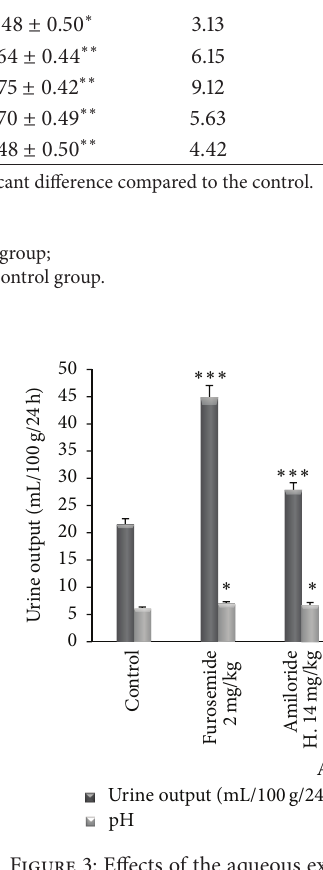
Table 2: Effects of the aqueous extract of F. glumosa on saluretic and natriuretic activity from 24 h of urine. Saluretic Drugs (mg/kg) Control Extract